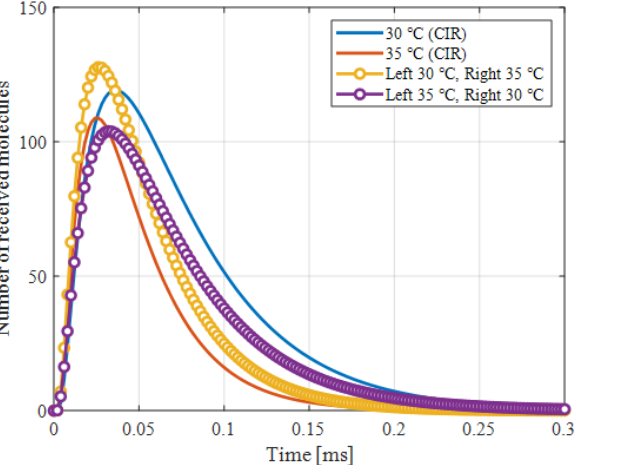
Figure 9. Number of received molecules when temperature distribution is